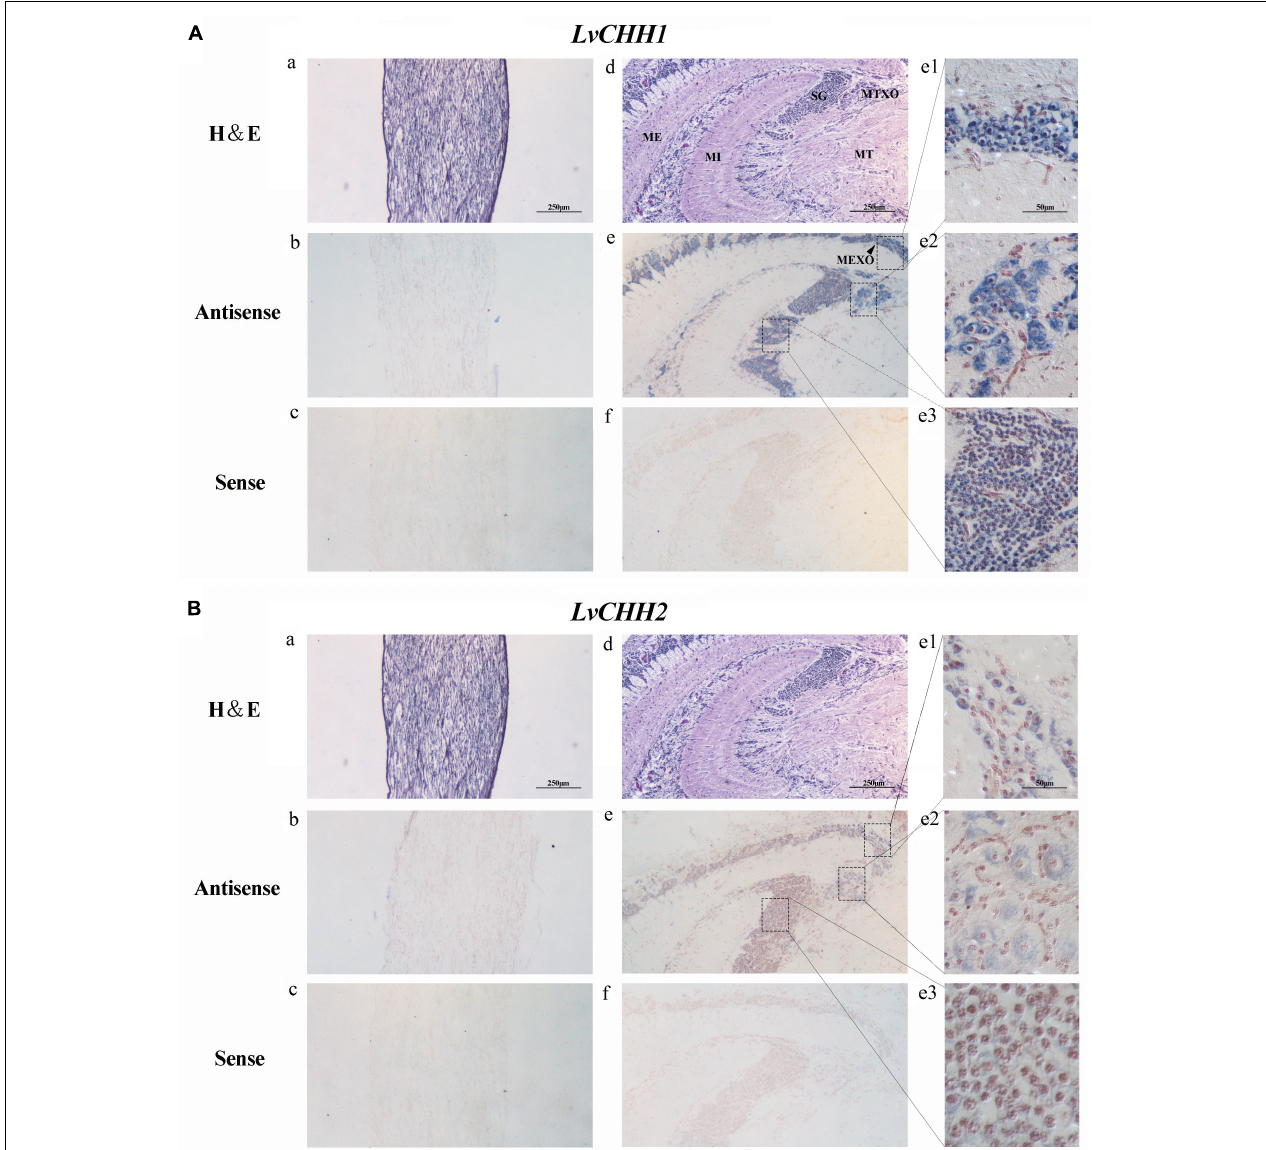
FIGURE 5 | Localization of LvCHH1 (A) and LvCHH2 (B) transcripts in the eyestalk of L. vannamei . Hematoxylin–Eosin (H&E) staining (a,d) and sense probe (c,f) were used as controls of the antisense probe hybridization (b,e) . Partial picture was enlarged into e1 (MEXO), e2 (MTXO), and e3 (SG). MTXO, medulla terminalis X-organ; MEXO, medulla externa X-organ; SG, sinus gland; MI, medulla interna; ME, medulla externa; MT, medulla